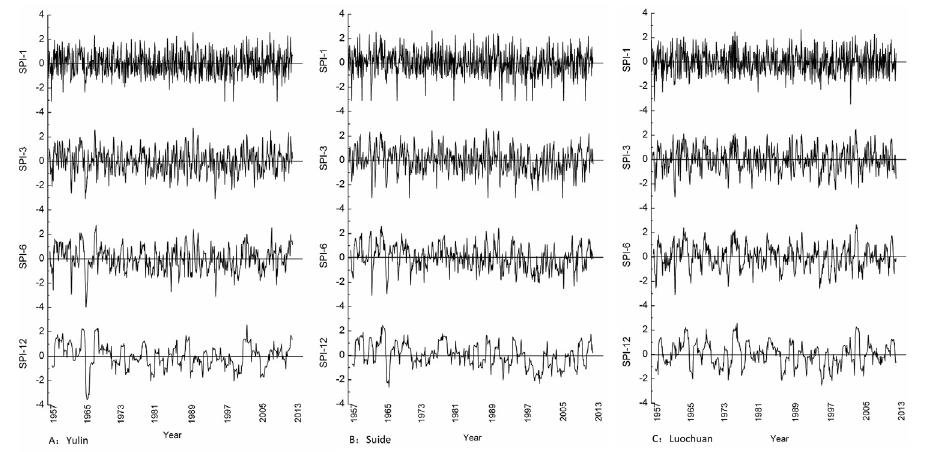
Fig 3. Different time scales of SPI (SPI-1, SPI-3, SPI-6, SPI-12) at 3 representative synoptic stations from north to south during 1957 – 2012.